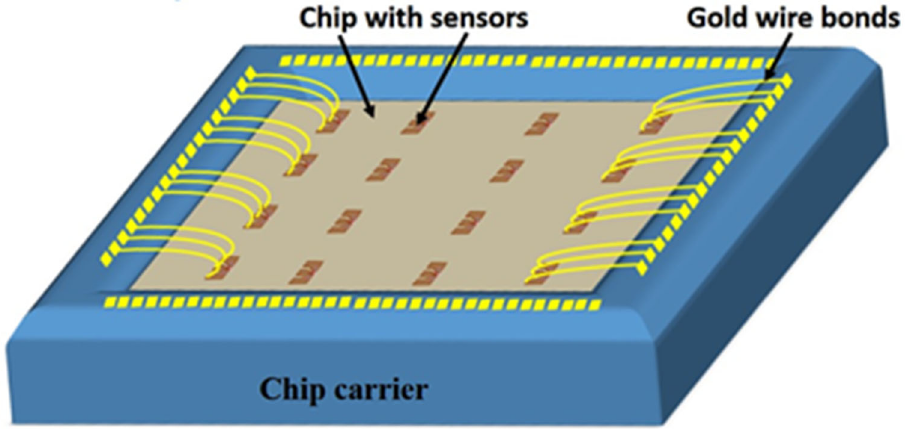
Figure 7. Schematic of the housing in which the chip structure is bonded to the chip carrier.